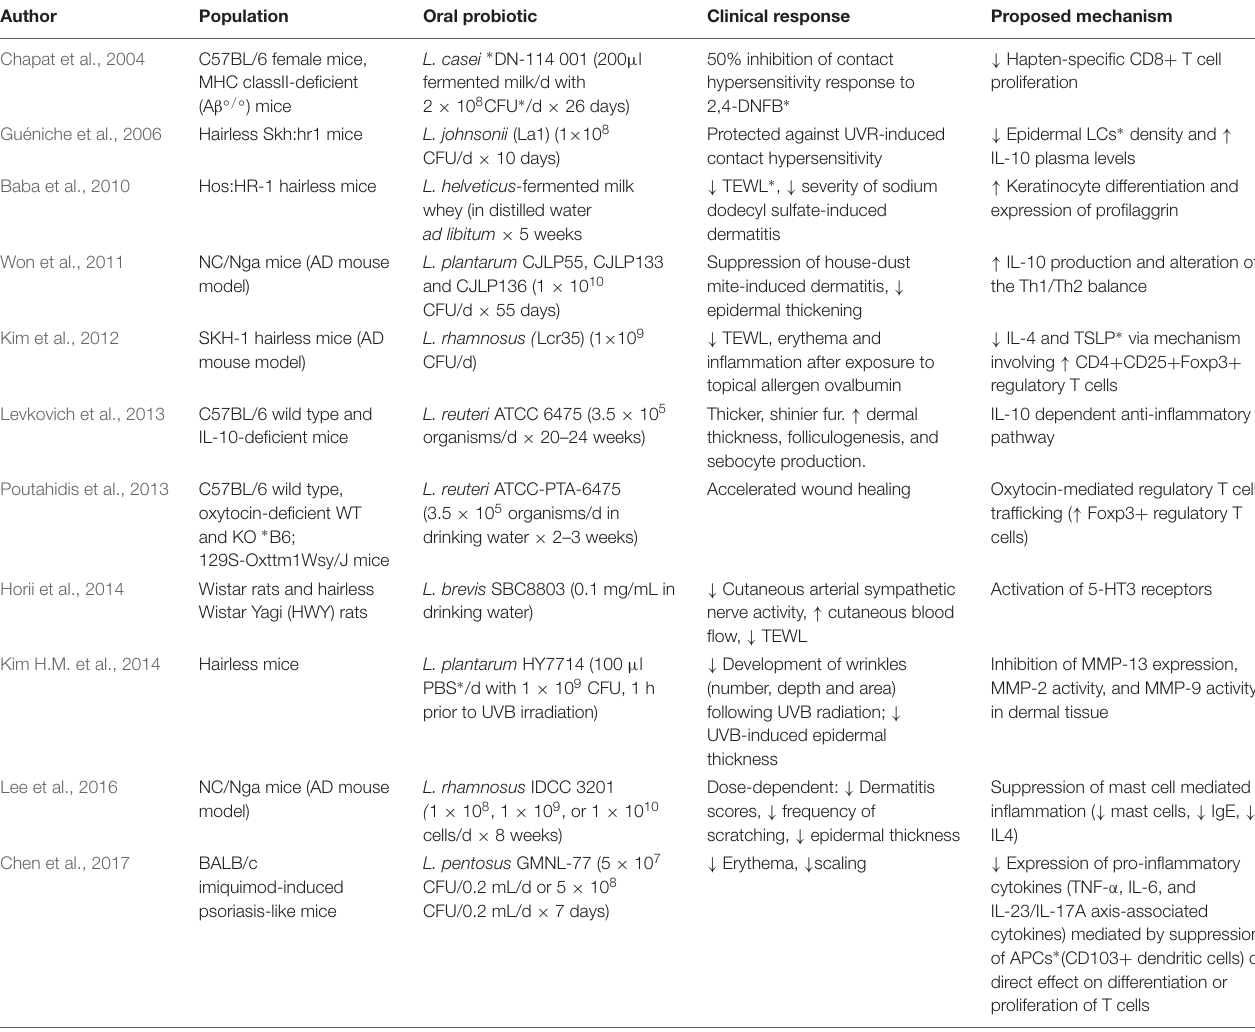
TABLE 1 | Evidence of beneficial probiotic interventions: animal